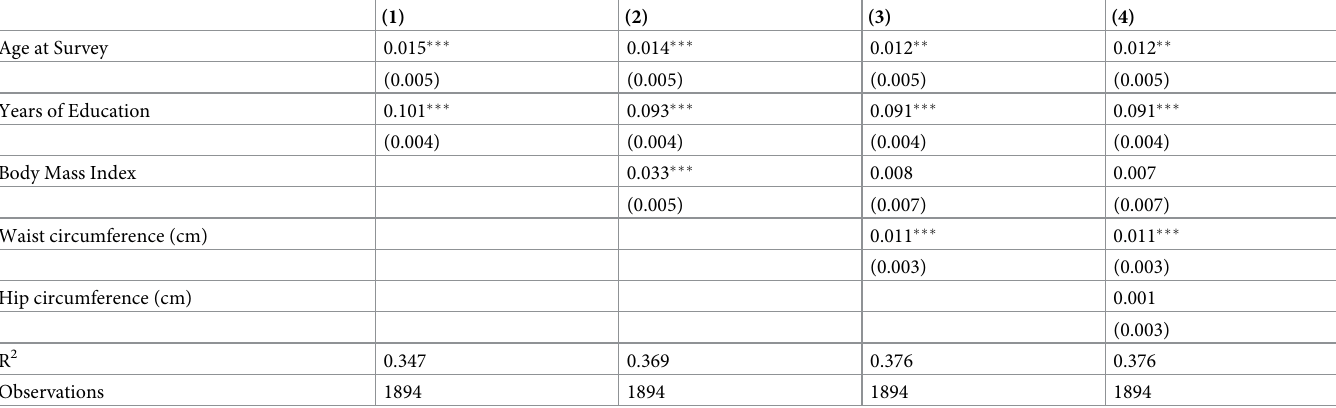
Table 2. Estimation results without individual fixed